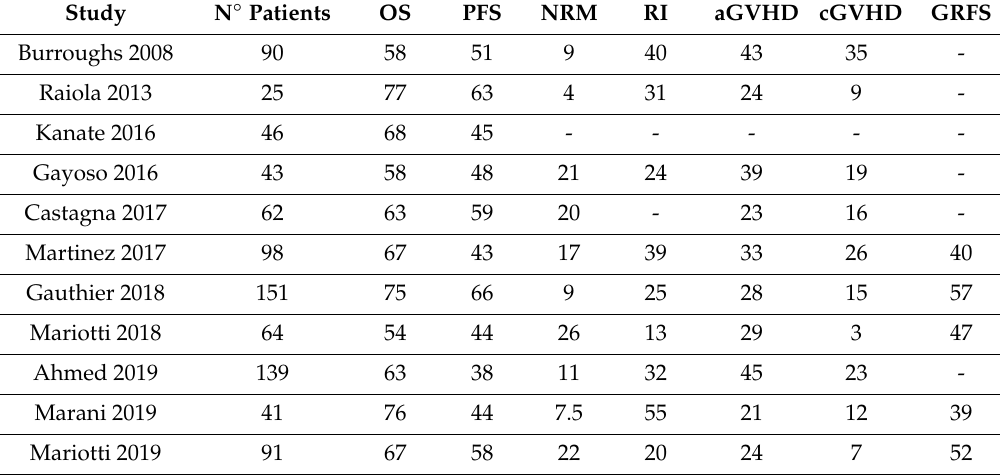
Table legend: OS: overall survival; PFS: progression free survival; NRM: non-relapse mortality; aGVHD: grade II-IV acute graft-versus-host-disease, cGVHD: chronic graft-versus-host-disease either mild-moderate-severe or moderate-severe according to di ff erent publications; RI: relapse incidence; GRFS: GVHD / relapse-free